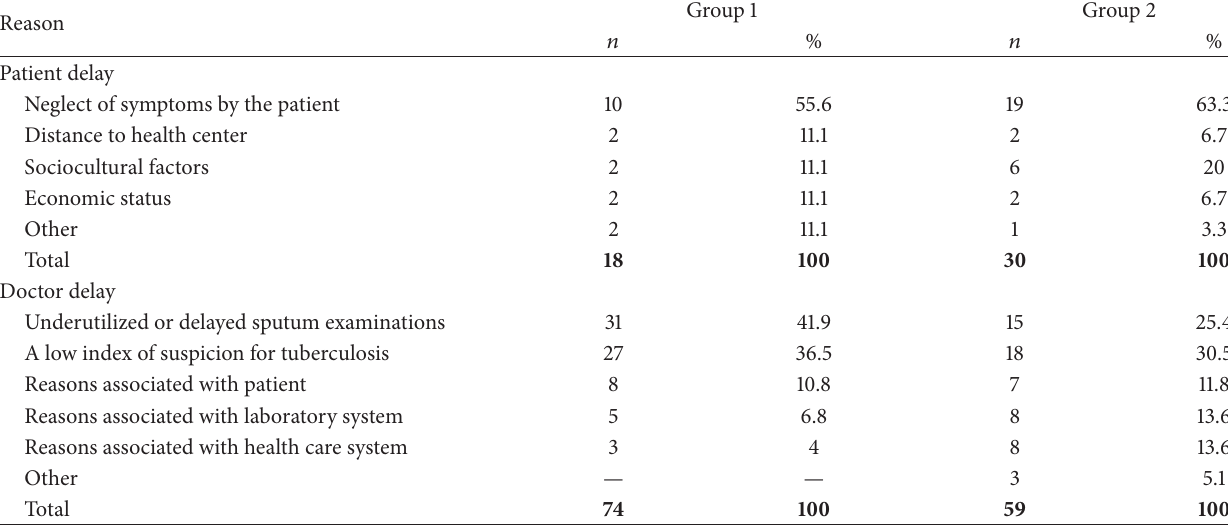
Table 4: Possible reasons for patient and doctor